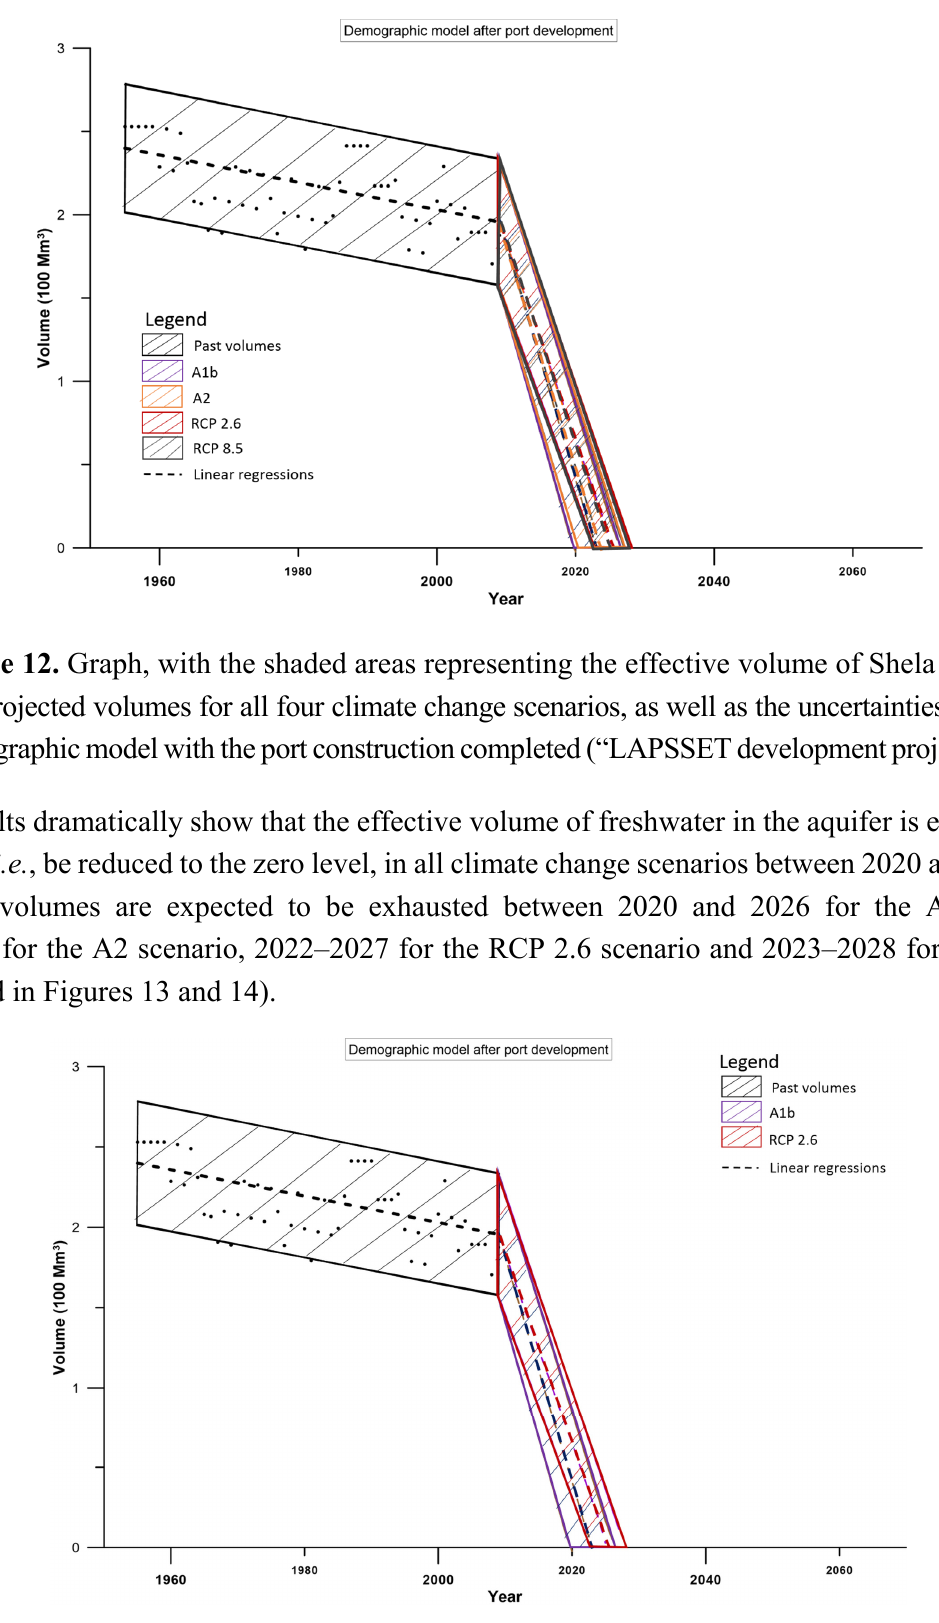
Figure 13. Graph, with the shaded areas representing the effective volume of Shela aquifer and projected volumes for A1b and RCP 2.6 climate change scenarios, as well as the uncertainties for the demographic model with the port construction completed (“LAPSSET